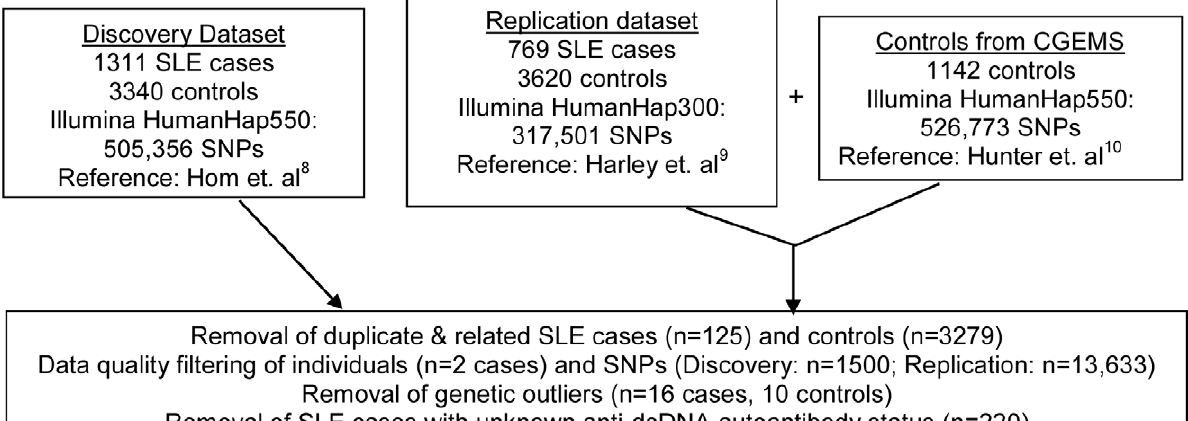
Figure 1. Overview of sample sizes and genotyping platforms used in this study.